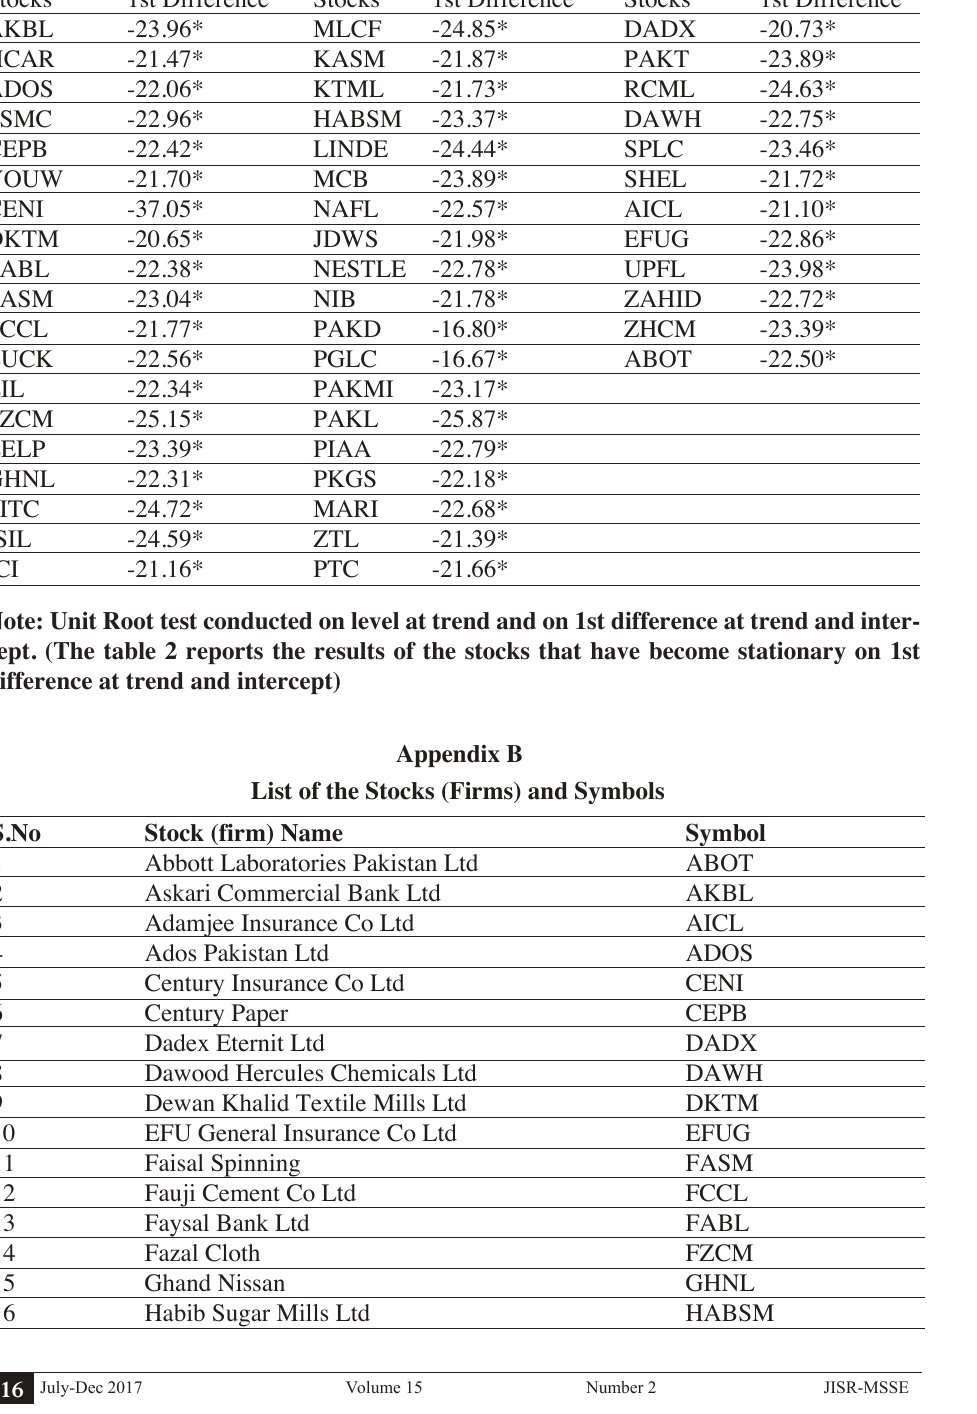
Table A2: Unit Root Test (Stock Returns)